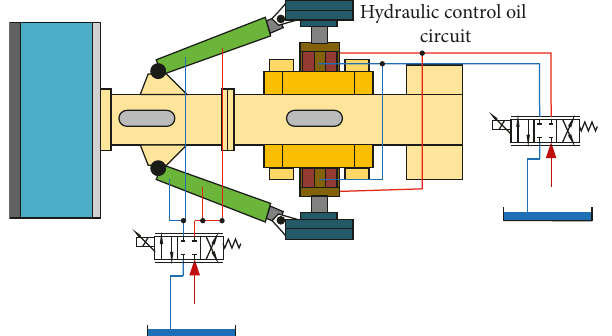
Figure 2: Schematic of the hydraulic system of the shield machine.